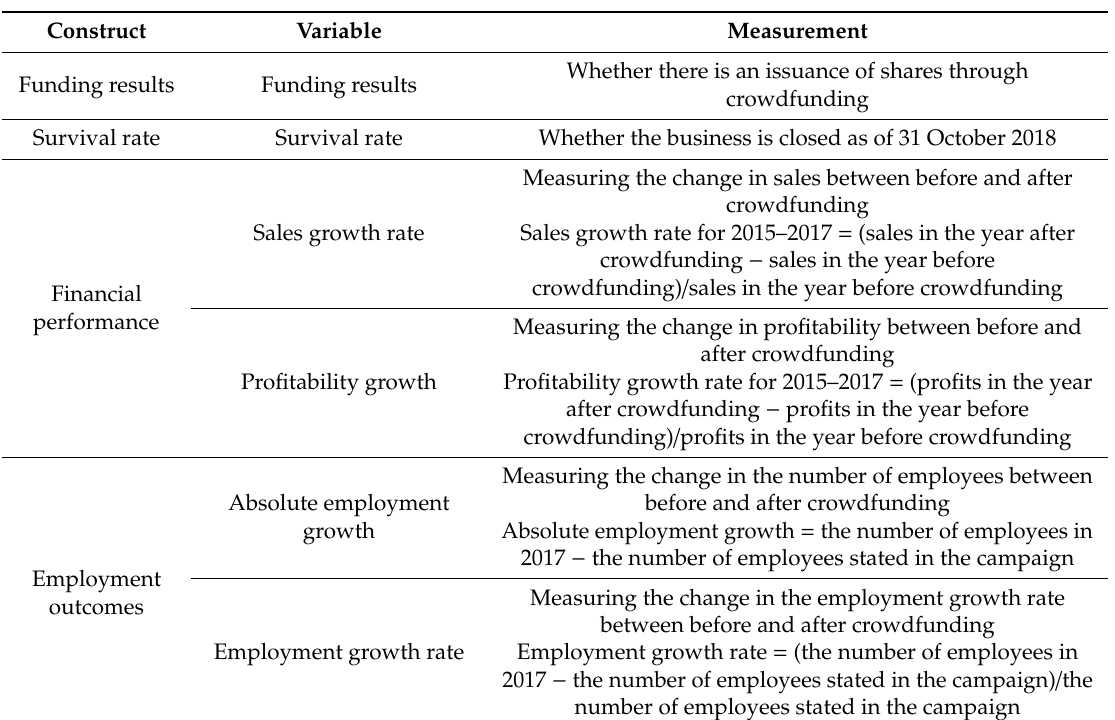
Table 3. Variable